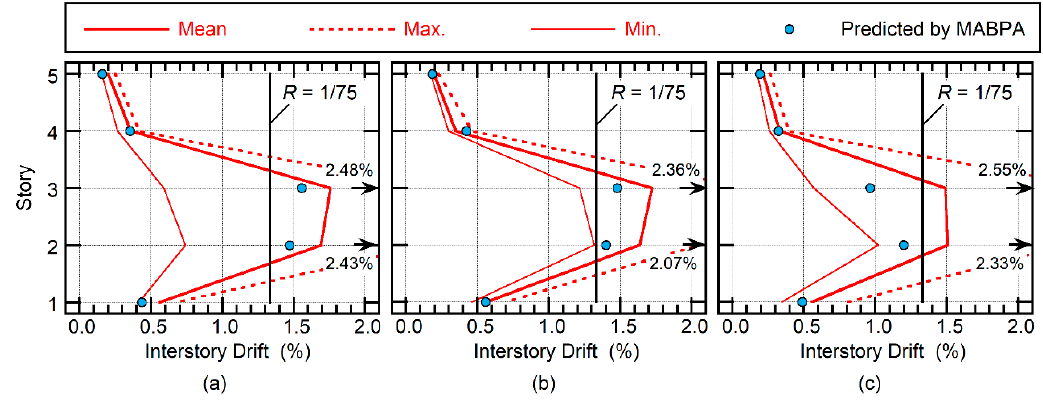
Original image of Figure 23: